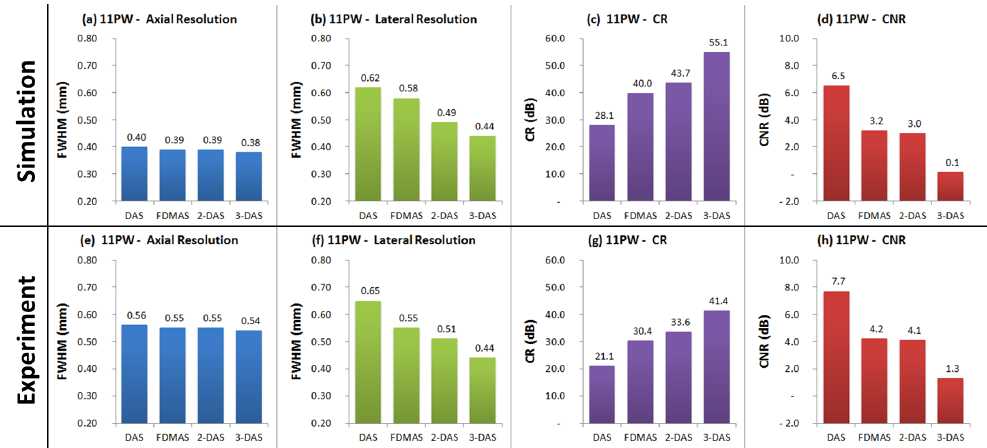
Figure 6. Performances obtained with DAS, FDMAS, 2-DAS, and 3-DAS beamformers, using 11 plane waves in simulation ( a – d ) and experiment ( e – h ). Results obtained are given for axial resolution ( a , e ), lateral resolution ( b , f ), contrast ratio ( c , g ), and contrast-to-noise ratio ( d , h